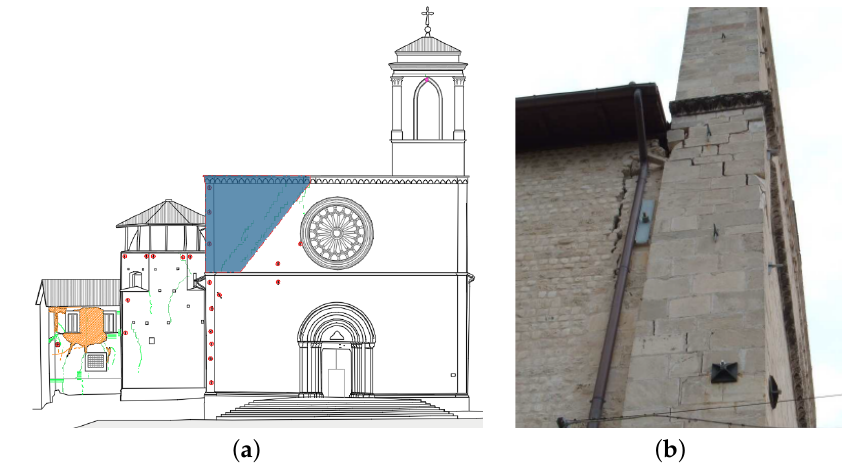
Figure 12. ( a ) Observed collapse mechanisms of the St.Silvestro facade; ( b )External view of the cracks, taken by Fine Art Authority.